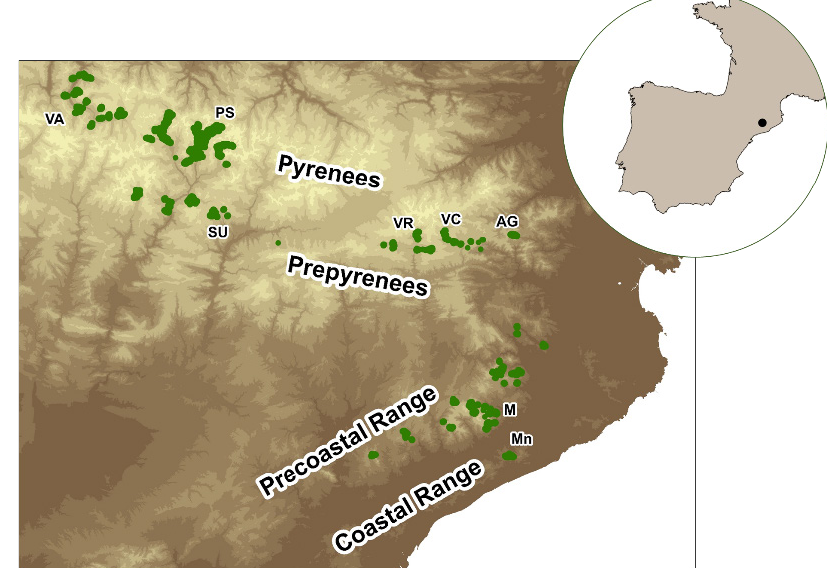
Figure 1. Sessile oak forests (green) on the NE Iberian Peninsula. Subregion abbreviations: